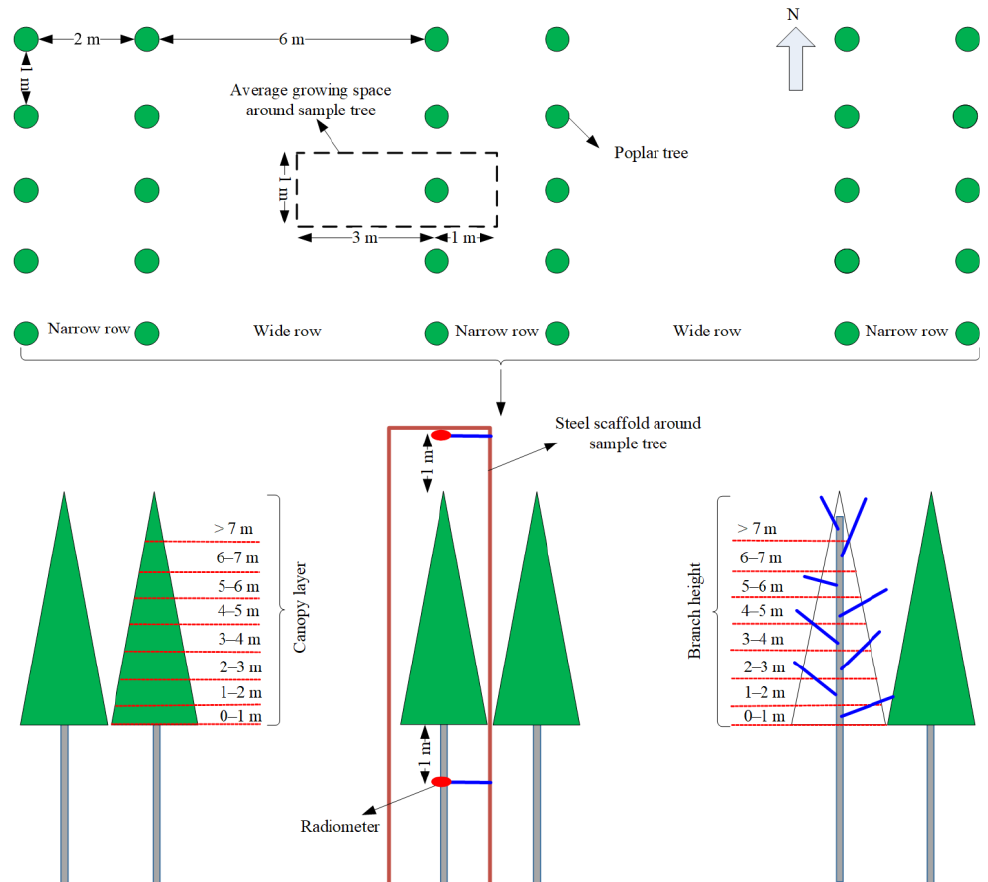
Figure 1. Schematic diagrams of the alternate wide- and narrow-row spacing planting scheme, the relative position of the sample tree, the installation patterns for dome net radiometers above and under the sample tree canopy, and the definitions of canopy layer and branch height used in this study.